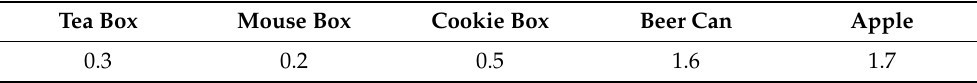
Table 3. Threshold of point cloud variance on target surface(cm 2 ).